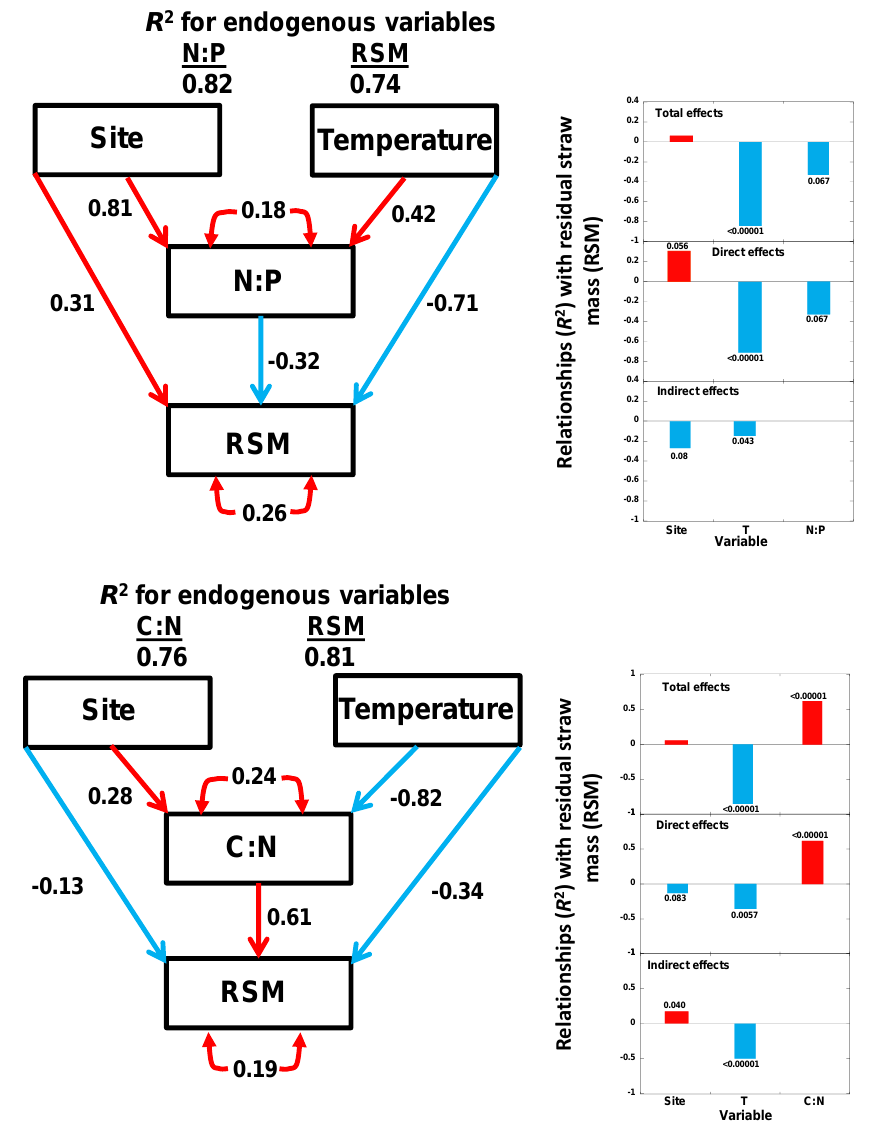
Figure 5. Diagrams of the structural equation models that best explained the maximum variance of the residual mass (RSM) with habitat (ridges and ditches) and soil traits as exogenous factors and the elemental composition and stoichiometric variables of the straw as endogenous variables. MRe, residual mass. Positive relationships are indicated by blue arrows and negative relationships with red arrows.